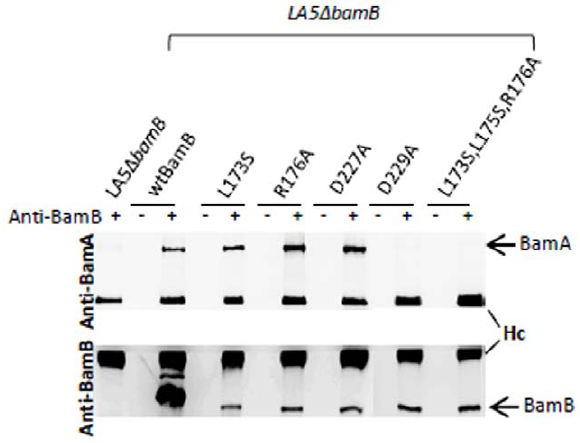
Figure 1. Effect of amino-acid substitutions in BamB proteins on the interaction of BamB with BamA. Co-immunoprecipitation of BamA with histidine-tagged BamB proteins was performed. Whole- cell lysates of the S. Enteritidis LA5 D bamB mutant or the LA5 D bamB mutant expressing wild-type BamB protein, BamB with the single L173S, R176A, D227A, D229A substitution or the triple-mutated L173S,L175S,R176A BamB protein were immunoprecipitated with ( + ) or without ( 2 ) polyclonal anti-BamB antibodies. Immunoprecipitated proteins were separated by SDS-PAGE, transferred onto a nitrocellulose membrane and the presence of BamB or BamA in the samples was visualized by western-blots using polyclonal anti-BamB or anti-BamA antibodies. Hc: immunoglobulin G heavy chain. These results are representative of three independent experiments.